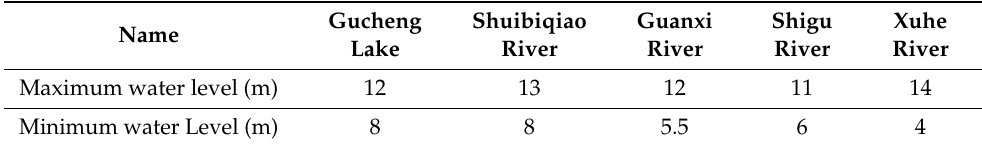
Table 2. Regulation water level of each main lake and river. Name